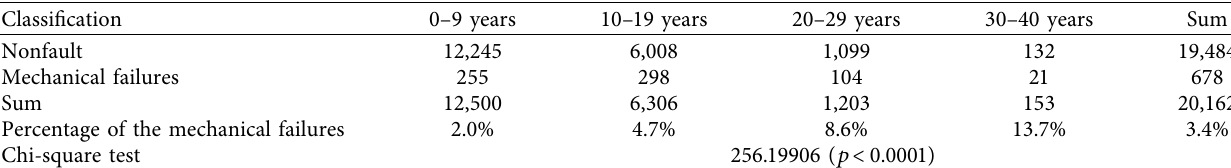
Table 3: Chi-square test with the contingency